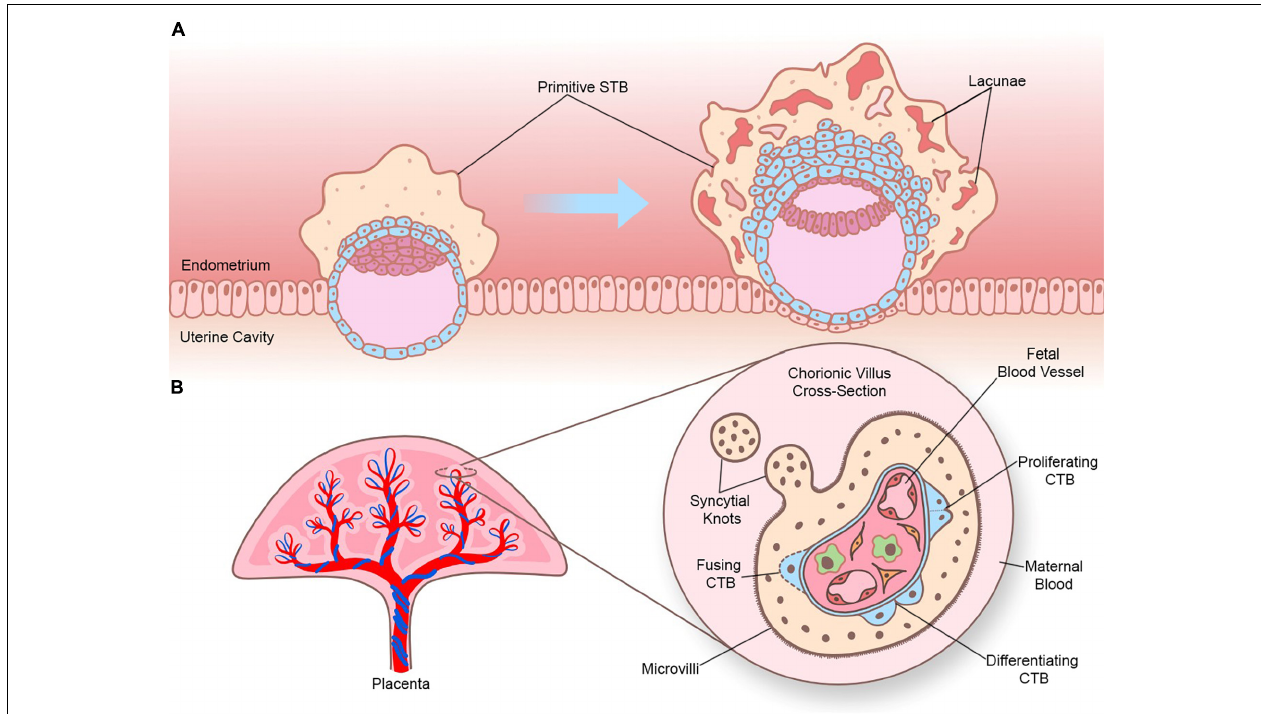
FIGURE 1 | Sequential development of STB. (A) Progression of a human embryo at approximately gestational days 7–8 (peri-implantation; left image) and days 9–10 (post-implantation; right image). Please note the invasive properties of the primitive STB at the forefront of the implanting human embryo and the gradual development of blood-filled lacunae. (B) Cross section of a chorionic villus in later gestation. Please note that the STB layer exhibits apical-basal polarity (as shown by the presence of microvilli) and bathes directly in maternal blood. An extruding syncytial knot is also shown. The villus core contains blood vessels that connect to the fetal circulation, as well as different cell types (such as Hofbauer cells and fibroblasts). CTBs are shown in various stages of their life cycle (proliferating, differentiating, and